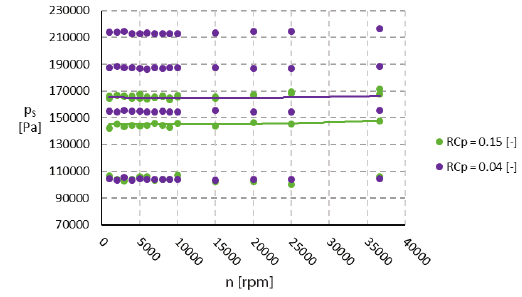
Figure 3. Boundary conditions